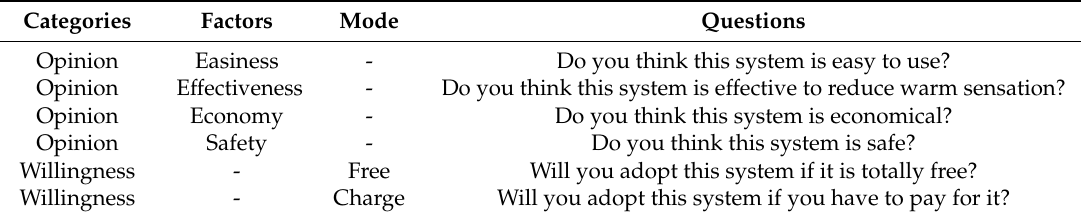
Table 5. Questions related to the comments on personal cooling systems in the